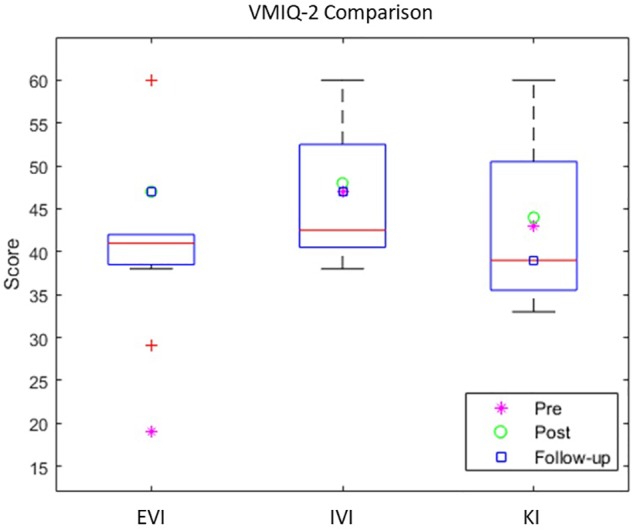
VMIQ-2 subscales comparison of Pre, Post and Follow-up scores with healthy data